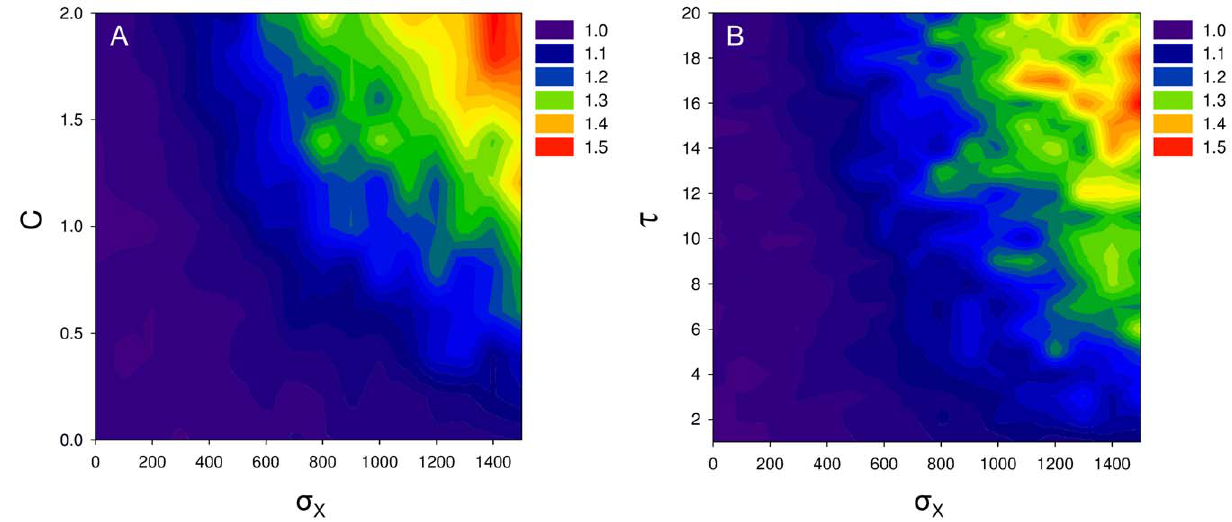
Figure 4. Selective advantage of cell-to-cell communication. Plot A shows the relative fitness benefit of cell-to-cell communication under different parameter conditions of s X and C (meaning the amount of environmental variation in the nutrient input and the amount of nutrients required for completing a single sporulation process). Plot B shows the relative fitness benefit of cell-to-cell communication under different parameter conditions of s X and t (meaning the amount of environmental variation in the nutrient input and the time-lag between the decision to sporulate and actually being a spore). The relative fitness is defined as the relative colony size of colonies that contain communicative cells over those that do not. Thus, when the relative fitness is bigger than one there is selection for cell-to-cell communication. For plot A we assume that t ~ 10 and for plot B we assume that C ~ 1 , hence the horizontal lines at which C ~ 1 in plot A and t ~ 10 in plot B are replicates of the same parameter conditions. The other parameter settings are the following: d cell ~ 0 : 05 , d spore ~ 0 : 0005 , P max ~ 0 : 1 , K X ~ 400 , D Signal ~ 0 : 5 , C CD ~ 2 : 0 , X Input ~ 2000 , N 0 ~ 100 , S 0 ~ 0 and T ~ 250 .